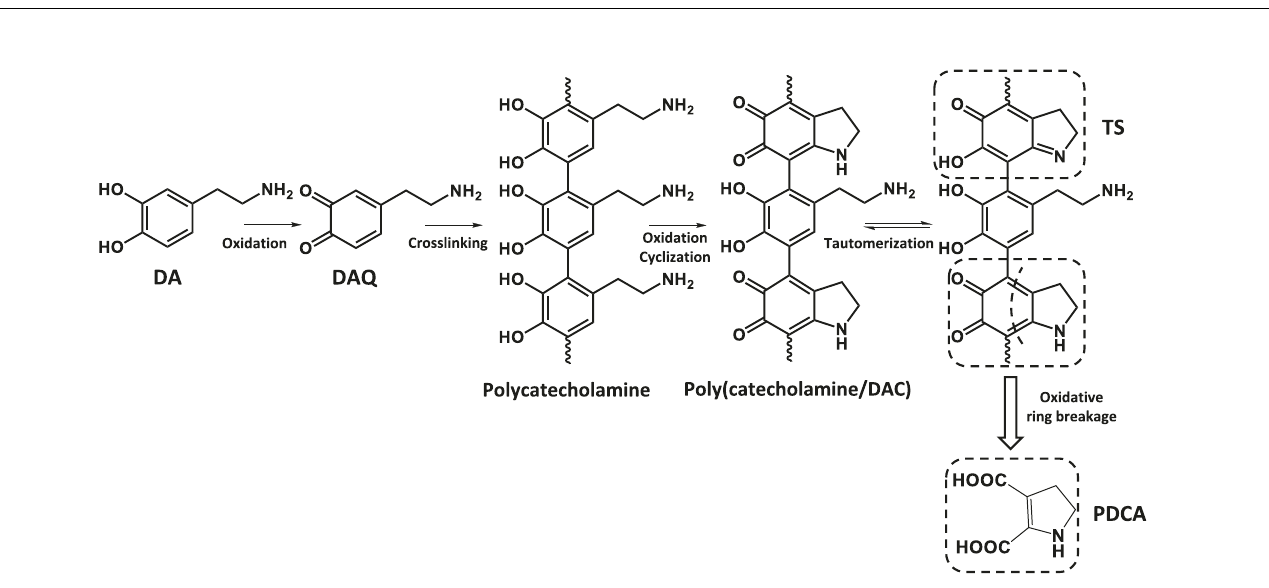
Fig. 8 | Relative percentage of polydopamine building block during fi lm for- mation. Time evolution of the concentration of the main building blocks as sketchedintheinsetduringpolydopamine fi lmformationonhalloysitenanotubes as deduced from the numerical model for: a dopamine, b dopamine quinone,